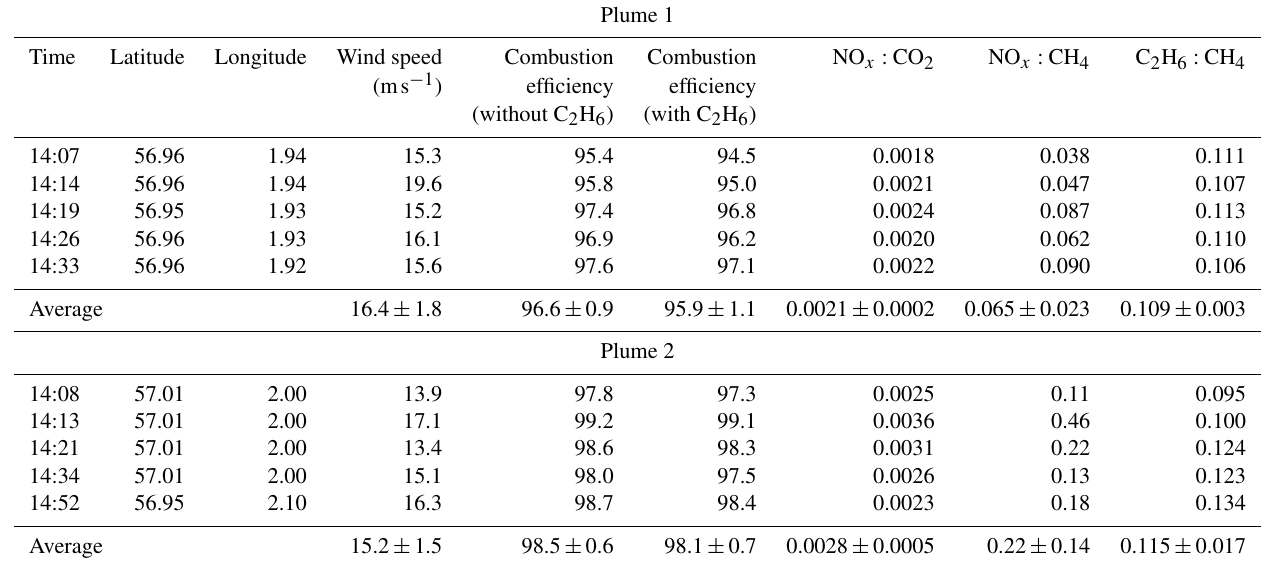
Table B1. Combustion efficiencies (with and without C 2 H 6 ) and emission ratios for peaks within two plumes sampled on 4 March 2019 (see Fig. B1).